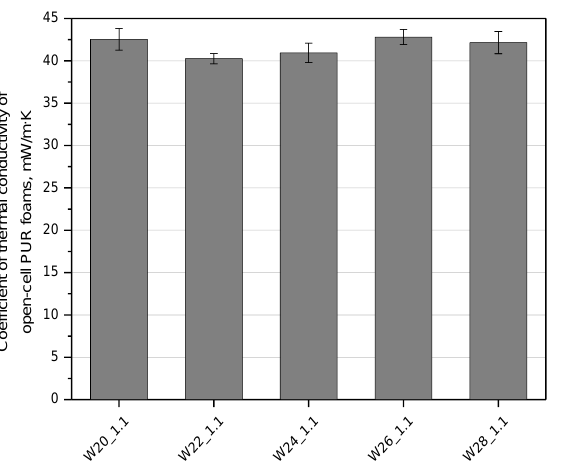
Figure 6. The coefficient of thermal conductivity of the open-cell PU foams with different amounts of water.